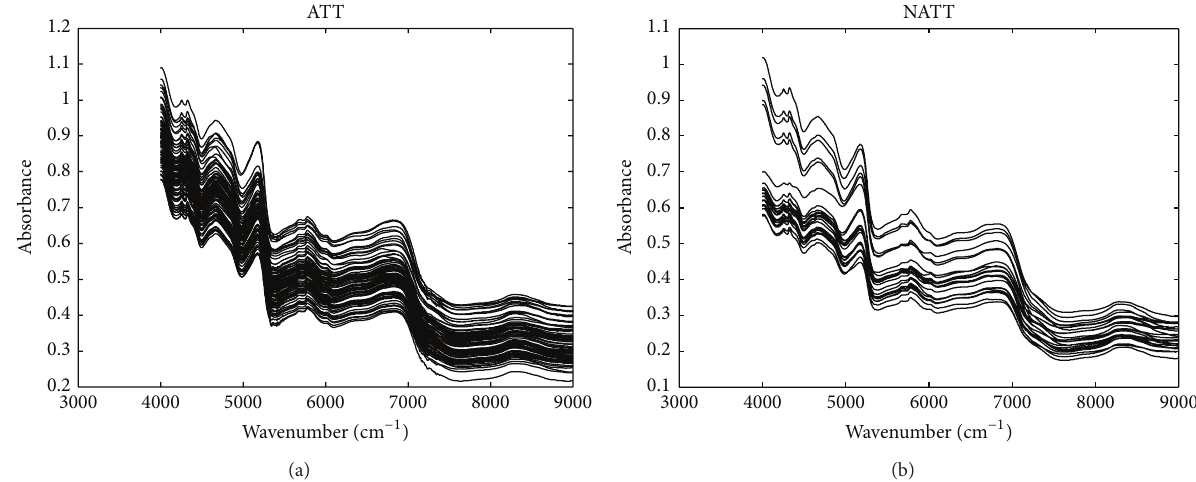
Figure 1: Some NIR raw spectra of Anxi-Tieguanyin (a) and non-Anxi-Tieguanyin (b) tea samples.